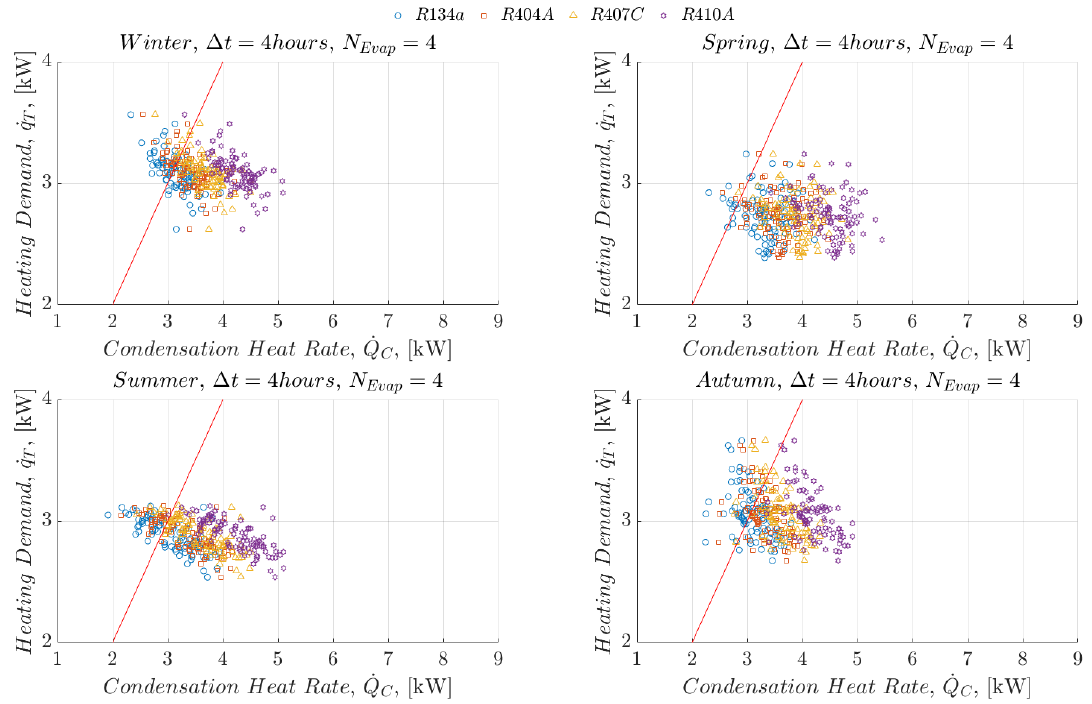
Figure 10. Thermal capacity seasonal density rate for all refrigerants and four collectors during 4 hours.